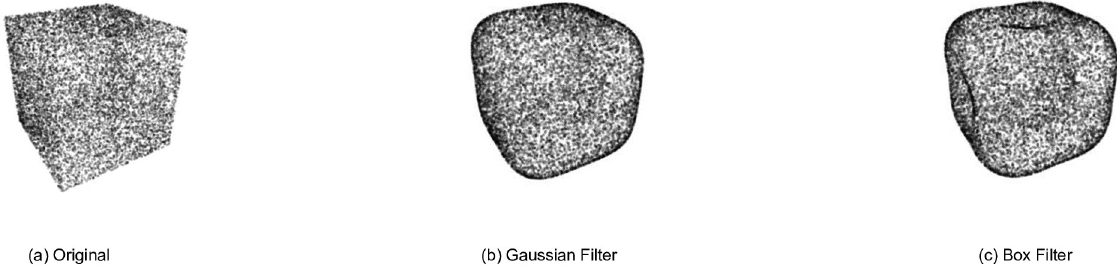
Fig 5. Effect of low pass filtering with Gaussian filter and Box filter. (a) Original point cloud. (b) Gaussian low-pass-filtered with S = 5. (c) Box filter when all frequency components of degree more than 5 are eliminated. Gaussian filter performs a more natural blurring effect than box-like filters, when ripples are seen in the flat regions on